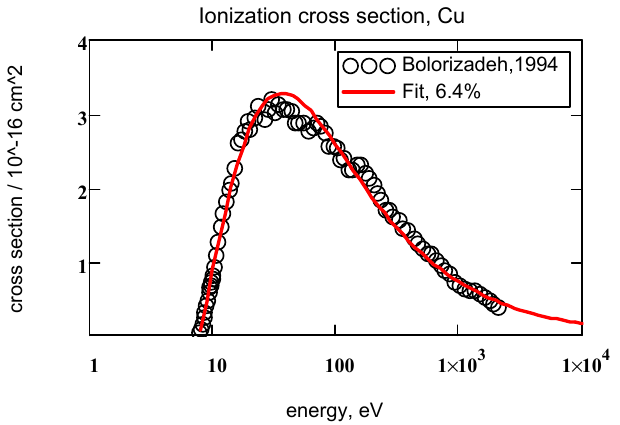
Figure 6. Experiment [29] and the result of approximation by the one − term Formula (6) of the ionization cross section of copper atoms with a mean square relative error of 6.4%.